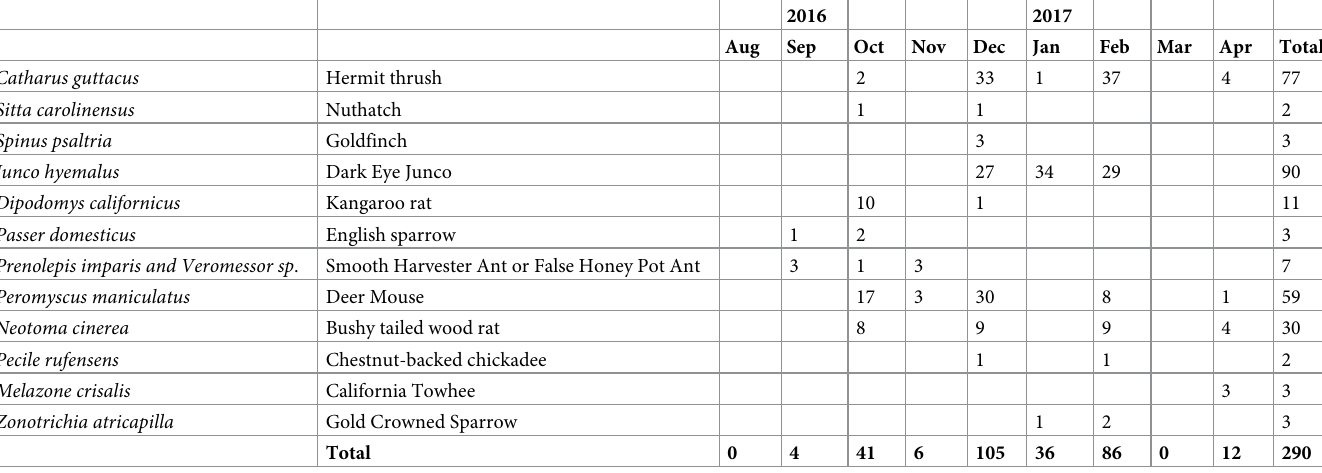
Table 1. Number of visits by species to seed trays as captured by motion-activated wildlife cameras. Mt. Diablo State Park. August 2016 to March